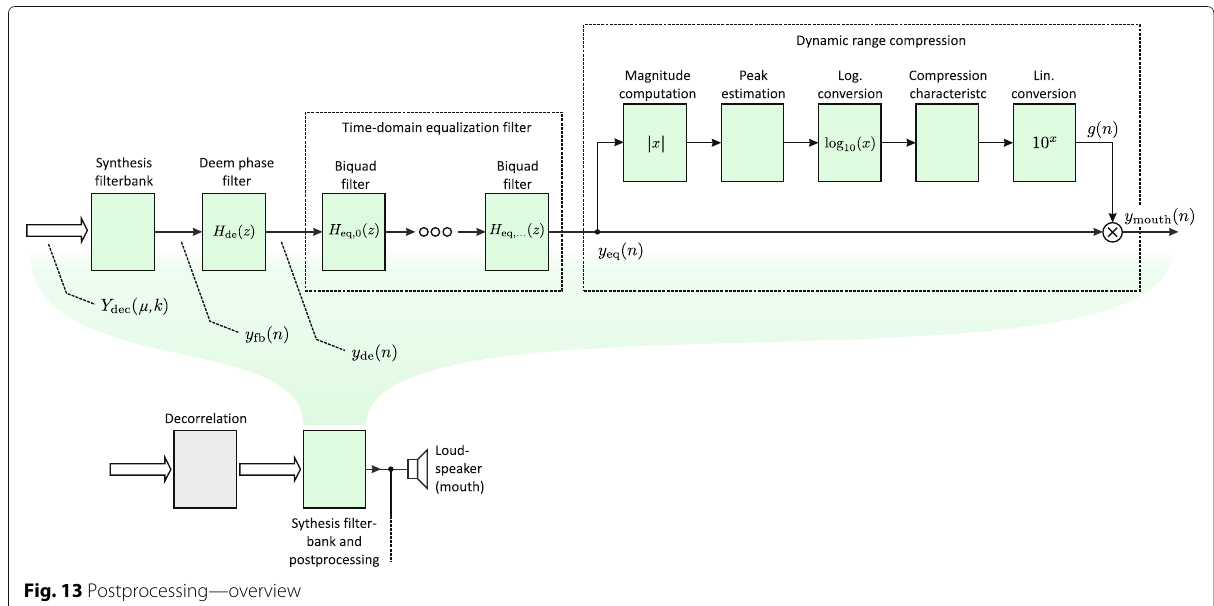
Fig. 13 Postprocessing—overview